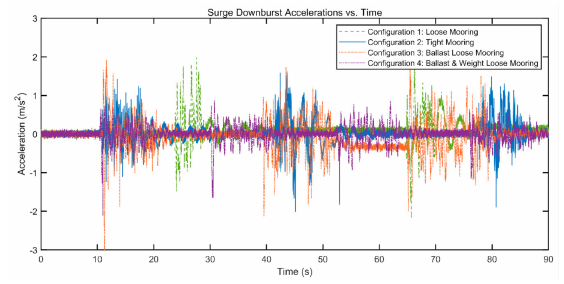
Figure A8. Downburst surge accelerations for all configurations.